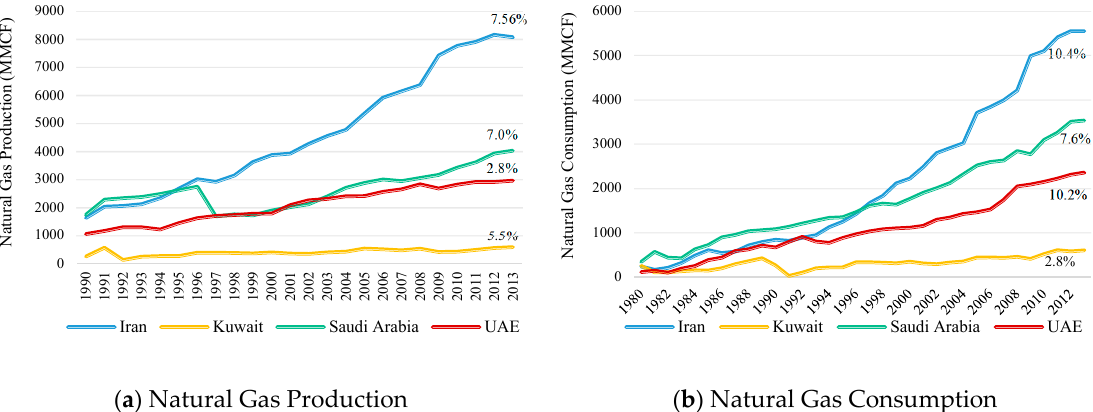
Figure 2. ( a ) Total natural gas production over the period (1990–2013); ( b ) natural gas consumption from 1980 to 2013. Percentages refer to the annual growth rate over the analysis period. Based on data from [17–19].